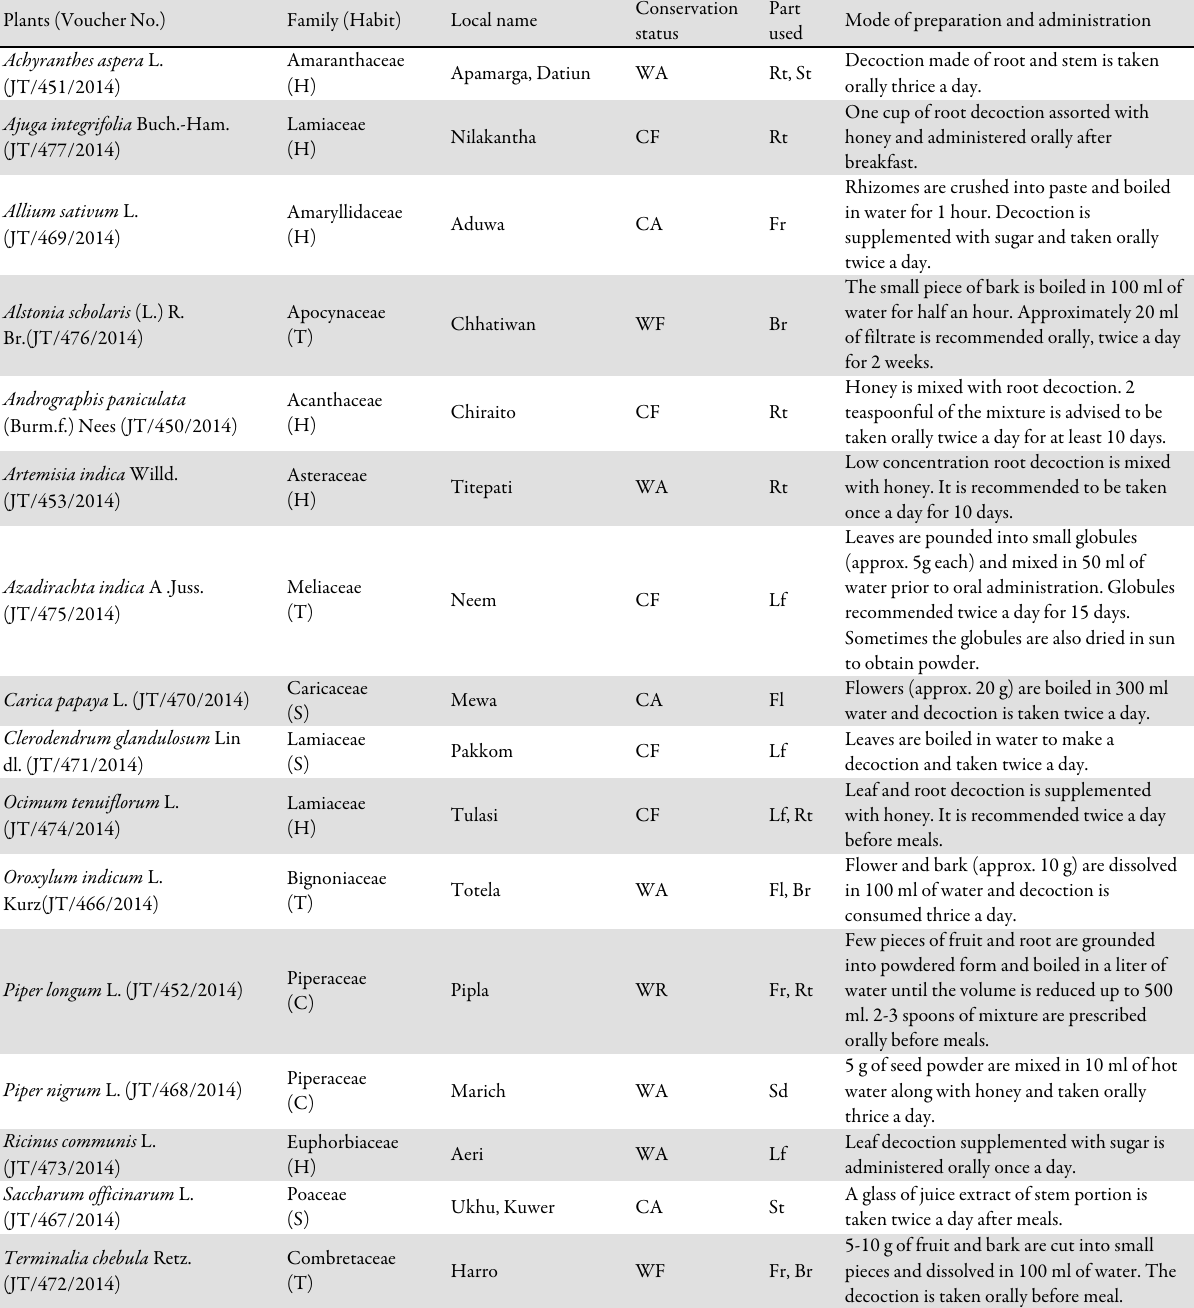
Table 1. Antimalarial plants used in Jonai, Assam, India Plants (Voucher No.) Family